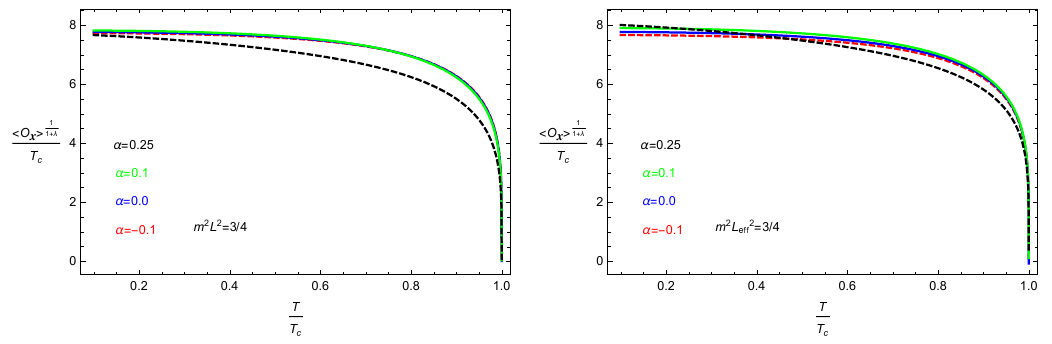
Figure 6 . The condensates of the vector operator O x as a function of temperature for the masses of the vector field m 2 L 2 = 3 / 4 (left) and m 2 L 2 = 3 / 4 (right). The four lines from bottom to top eff correspond to increasing Gauss-Bonnet parameter, i.e., α = − 0 . 1 (red and dashed), 0 . 0 (blue), 0 . 1 (green) and 0 . 25 (black and dashed), respectively.